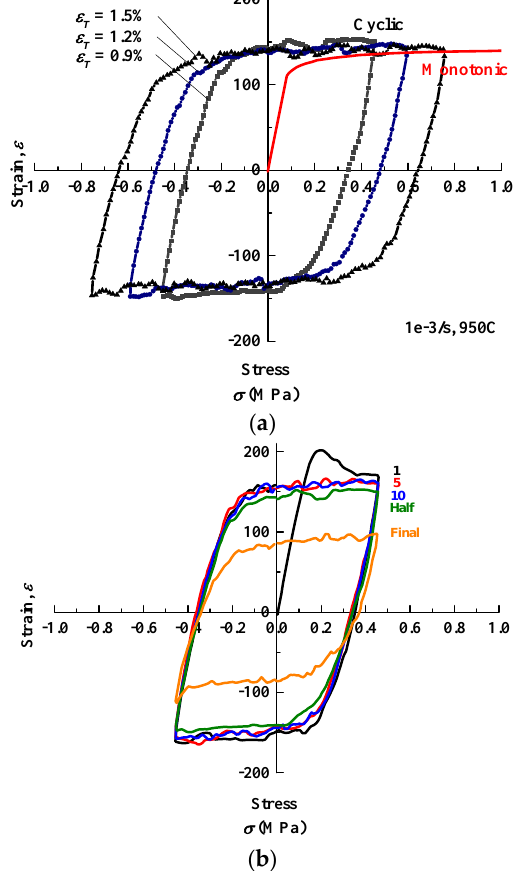
Figure 5. Stress–strain hysteresis loops plotted at: ( a ) Half-life cycle under different total strain ranges; ( b ) Interval hysteresis loops for the 0.9% total strain range of Alloy 617 at 950 °C.